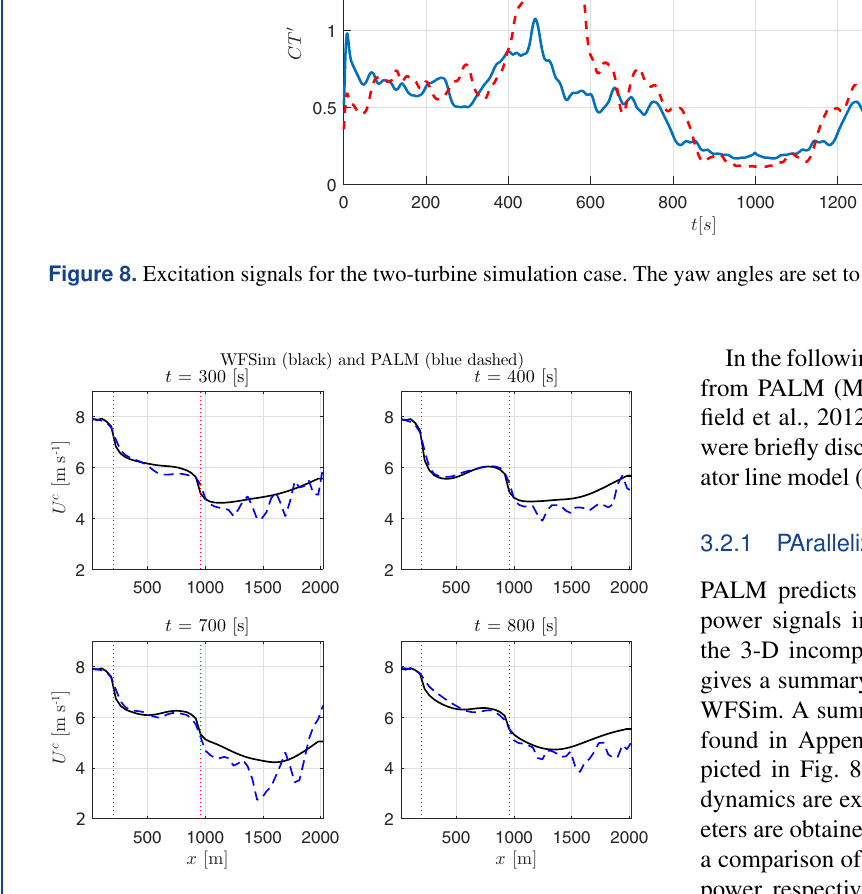
Figure 9. Mean flow centreline at four time instances through the farm. The vertical red dashed lines indicate the positions of the tur-